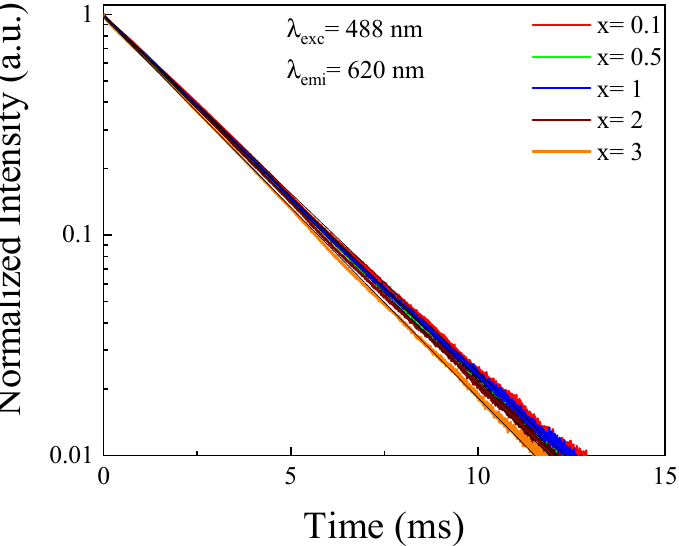
Figure 3. Decay curves of Tb 3+ in 2.5Tb 3+ -xYb 3+ co-doped phosphate glasses. Figure 4 exhibited the decay curves of Yb 3+ : 2 F 5/2 levels in the 2.5Tb 3+ -xYb 3+